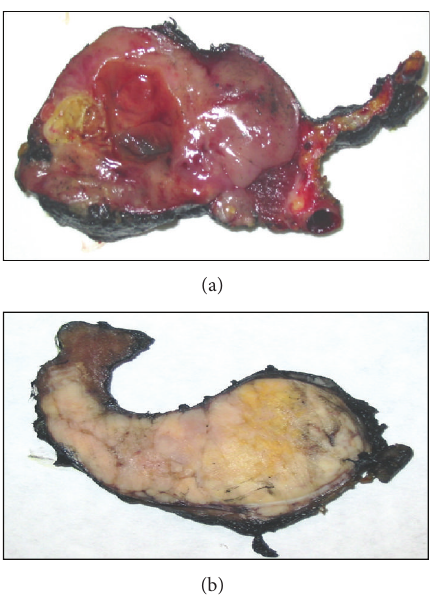
Figure 1: Grossly, ATC shows a diffusely infiltrative pattern of growth. The cut surface can be brownish (a) or whitish (b); in both specimens discrete yellowish areas of necrosis are evident.